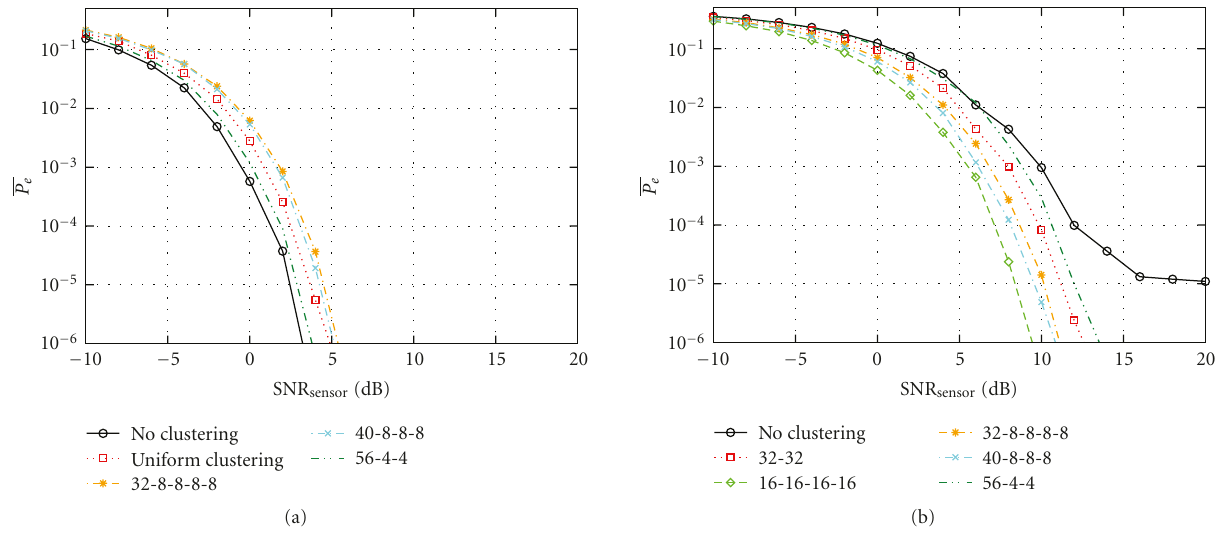
Figure 6: P e as a function of the sensor SNR, for di ff erent clustering configurations, ideal communication links, and weighing strategy at the AP. Case (a): ideal MAC; case (b): IEEE 802.15.4